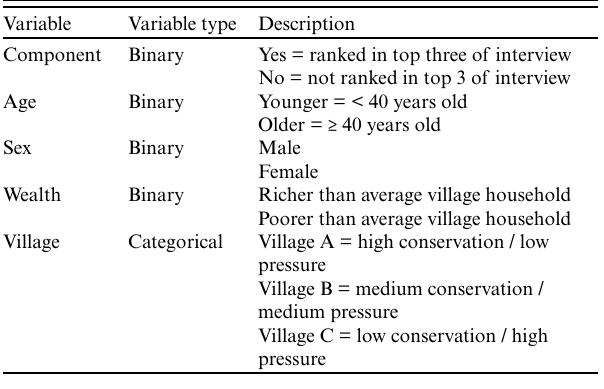
Table 2. Variables used in regressions as main predictors of variation in human